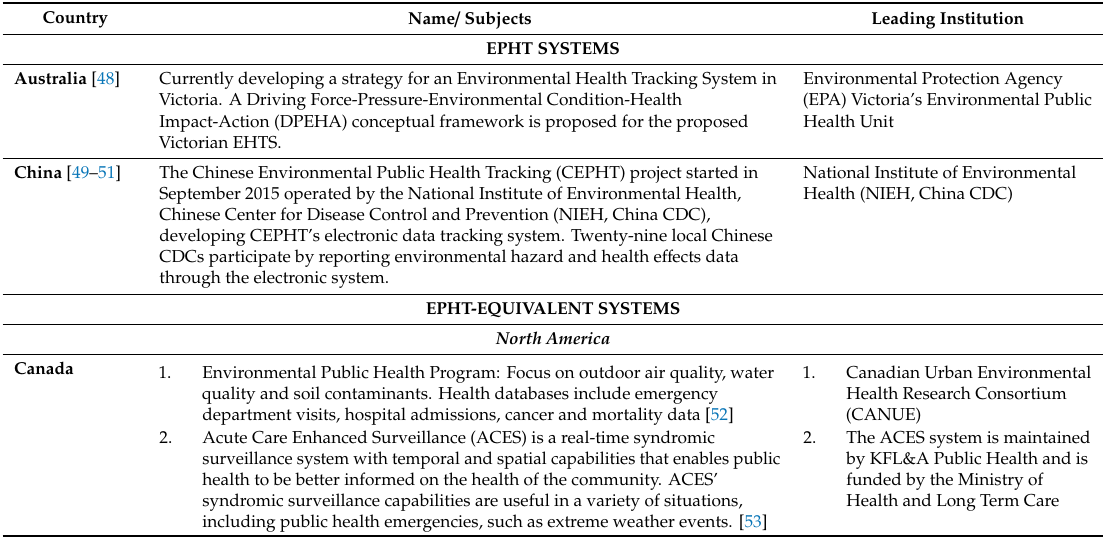
Table 1. Tracking activities around the globe that are collaborating in an international EPHT network (INPHET)